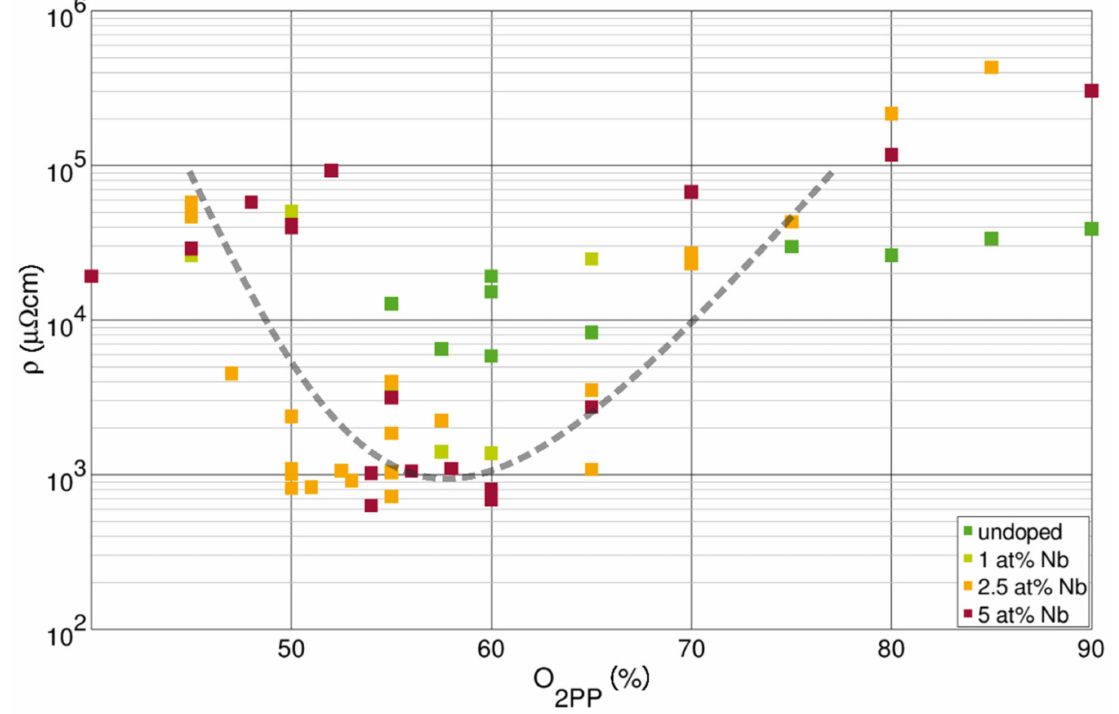
Figure 1. Room temperature resistivity of undoped and Nb-doped TiO 2 − x films after annealing as a function of the relative O 2PP during the sputter process. A line is given as a guide to the eye to illustrate the overall trend. A minimum of 620 µ Ω cm could be reached at 55% O 2PP with 5 at%